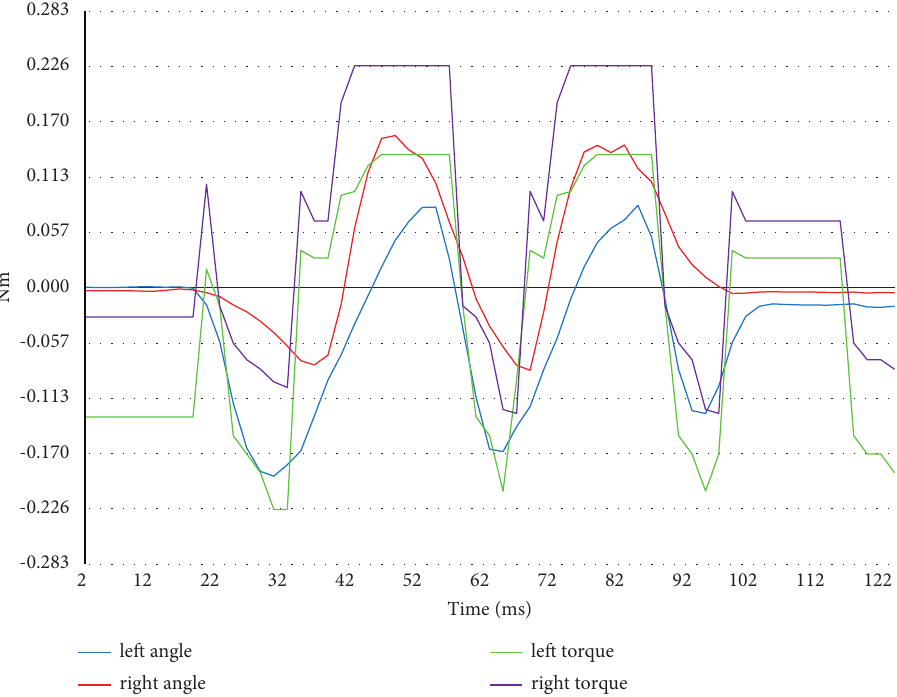
Figure 12: Assistive torque generated for the left and right hip joints for a faster walking